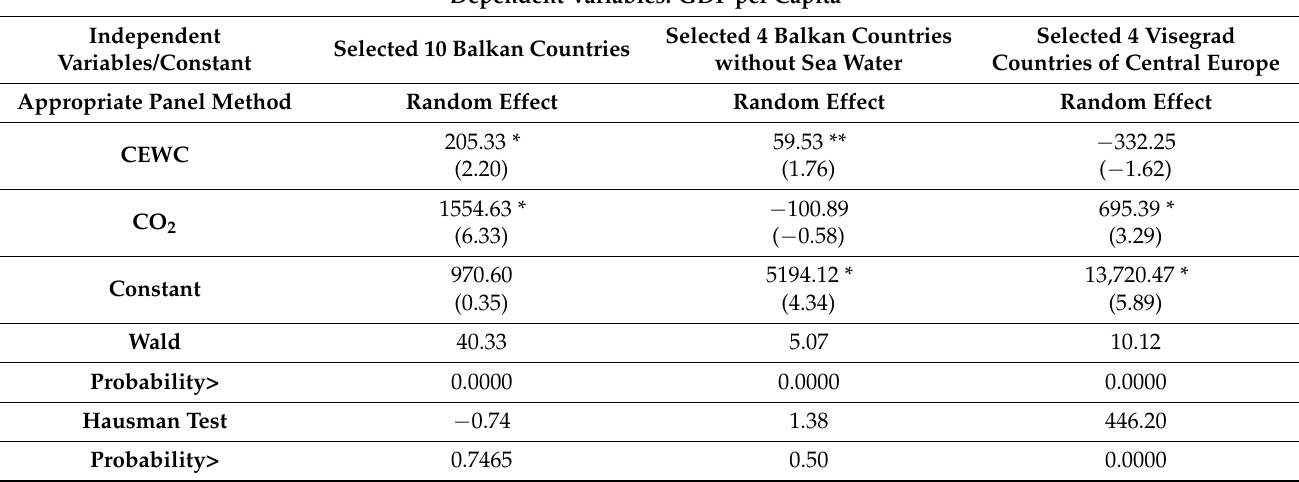
Table 4. Regression